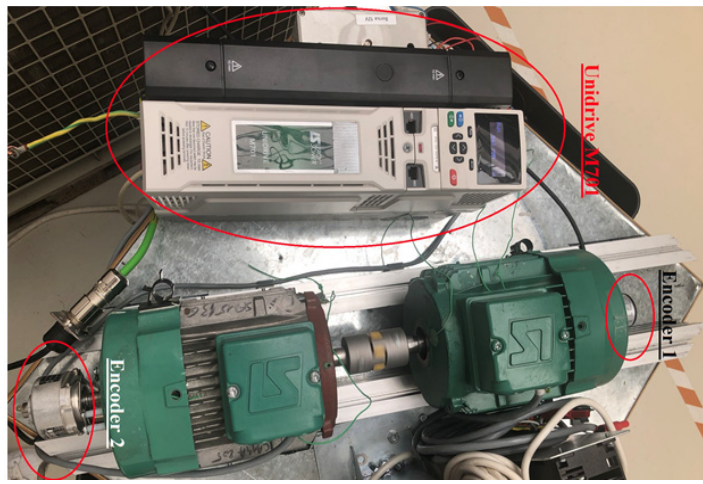
Figure 8. Photo of the experimental setup.